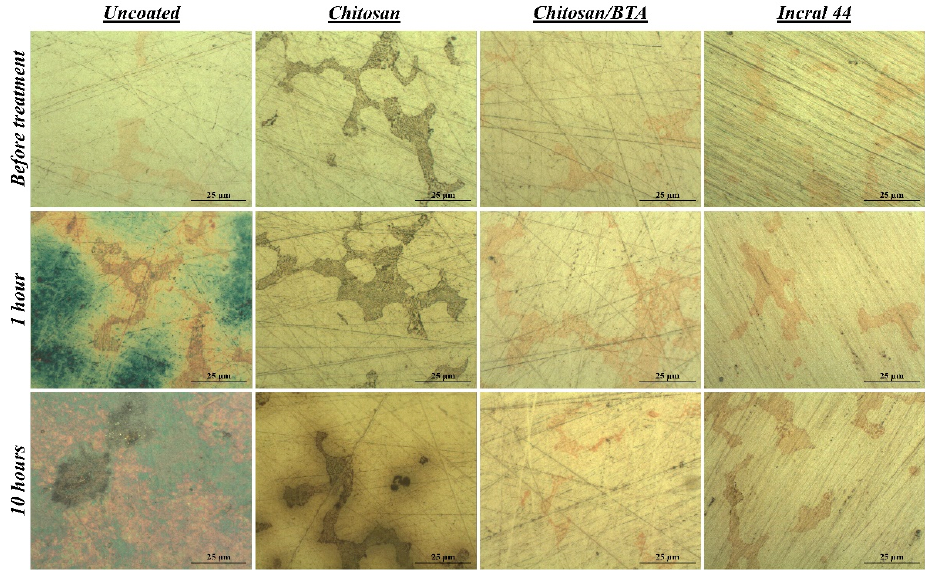
Figure 2. Surface features before and after the accelerated corrosion test. Optical microscopy images of a bare, a chitosan, a chitosan/BTA and an Incralac 44 coated disk at different times of artificial aging treatment.